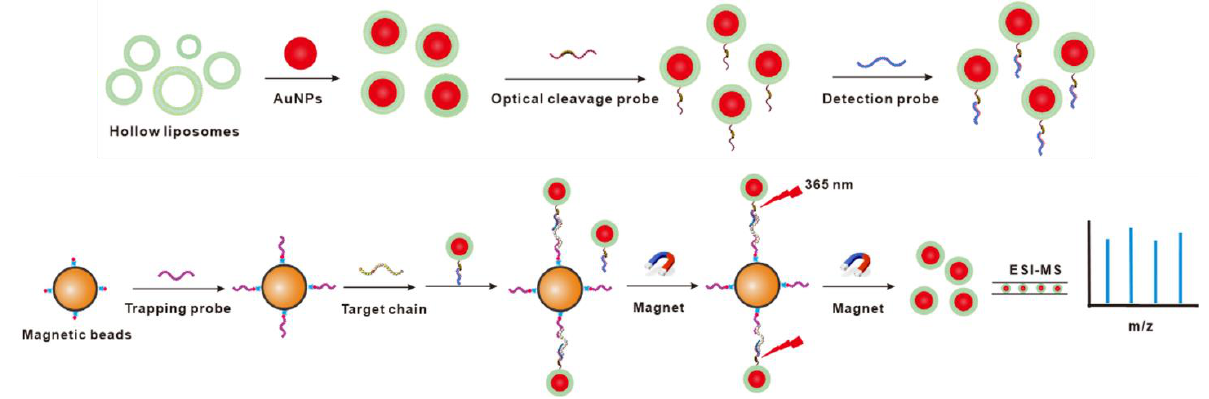
Figure 1. Schematic diagram of nucleic acid detection via liposome signal amplification in mass spectrometry.